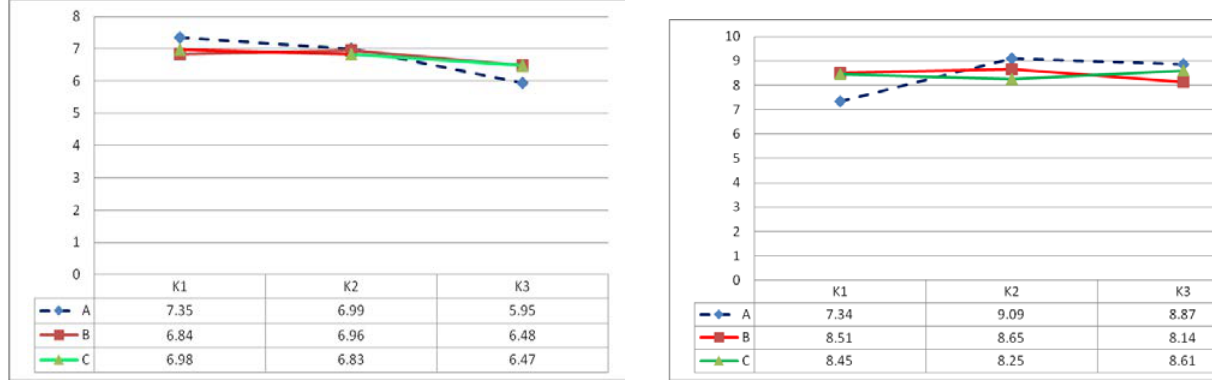
Figure 5: Relationship between the factors, the levels, and the K values (carbon fiber).